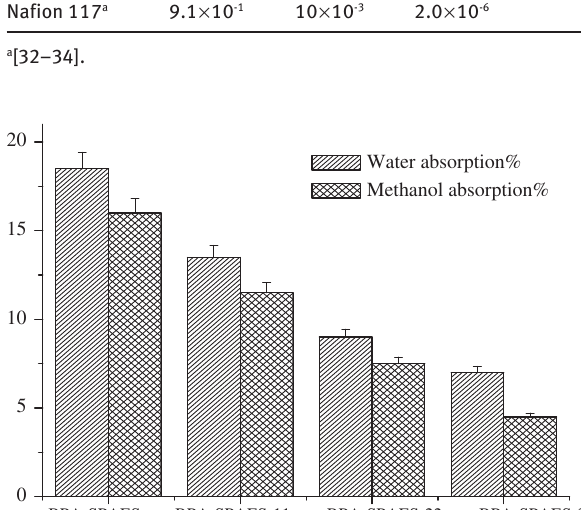
Figure 5: Water and methanol absorption.